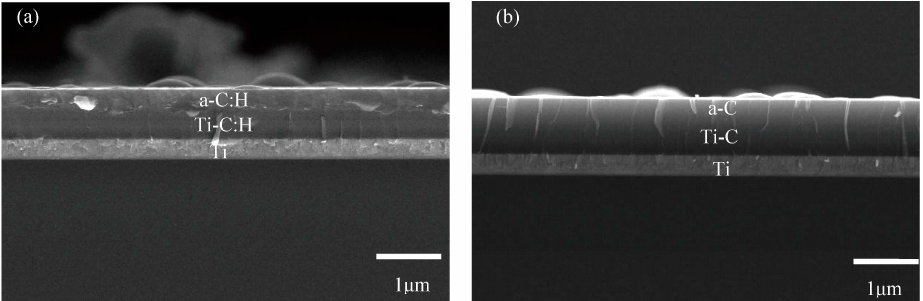
Figure 2. Cross-section field emission scanning electron microscope (FE-SEM) micrographs of ( a ) a-C:H, ( b ) a-C.